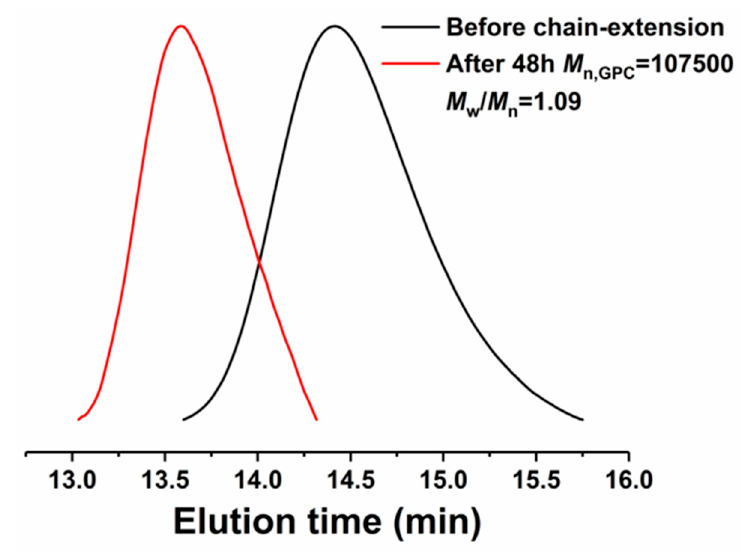
Figure 4. Gel permeation chromatography (GPC) traces of polymers obtained from chain-extension experiment.